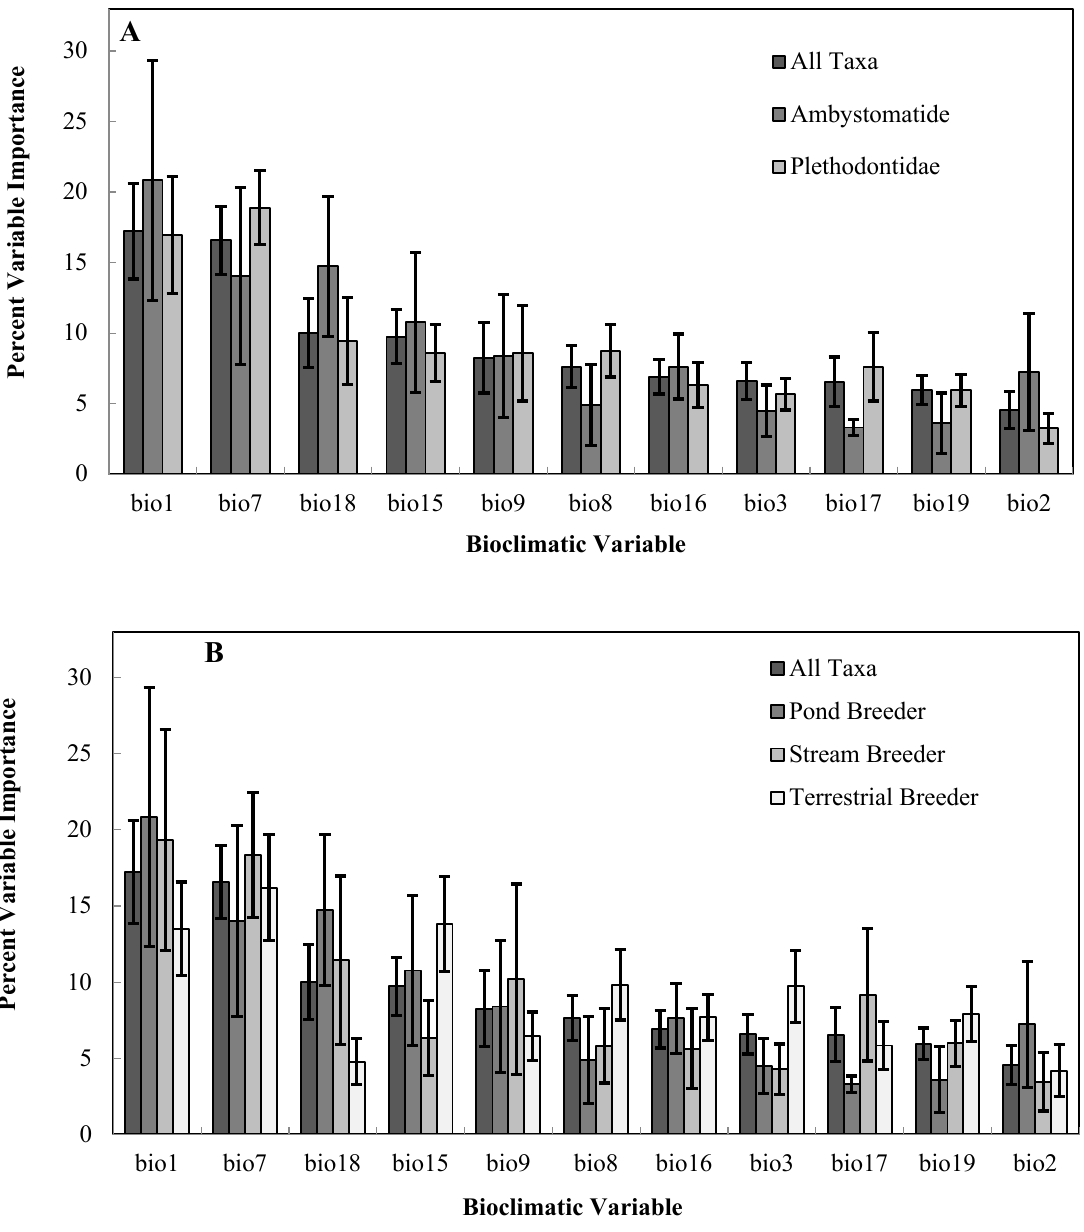
Figure 3. Average percent contribution of individual bioclimatic variables for predicting the climatic niche of priority salamander species, ( A ) by family and ( B ) salamander breeding category. Please see Table 4 for a description of bioclimatic variables. Within the current-day climatic scenario, the Central Appalachians, Western Allegheny Plateau, and Ridge and Valley geographic provinces were predicted to provide the greatest relative salamander climate refugia richness, whereas the Acadian Plains and Hills, Middle Atlantic Coastal Plain, Northeastern Coastal Zone, and Atlantic Coastal Plain Barrens were predicted to provide the least salamander climate refugia richness (Table 1, Figures 1 and